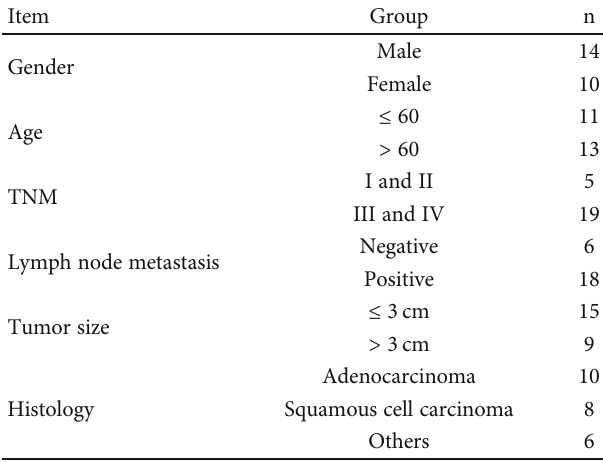
Table 1: Detailed characteristics of 24 patients with